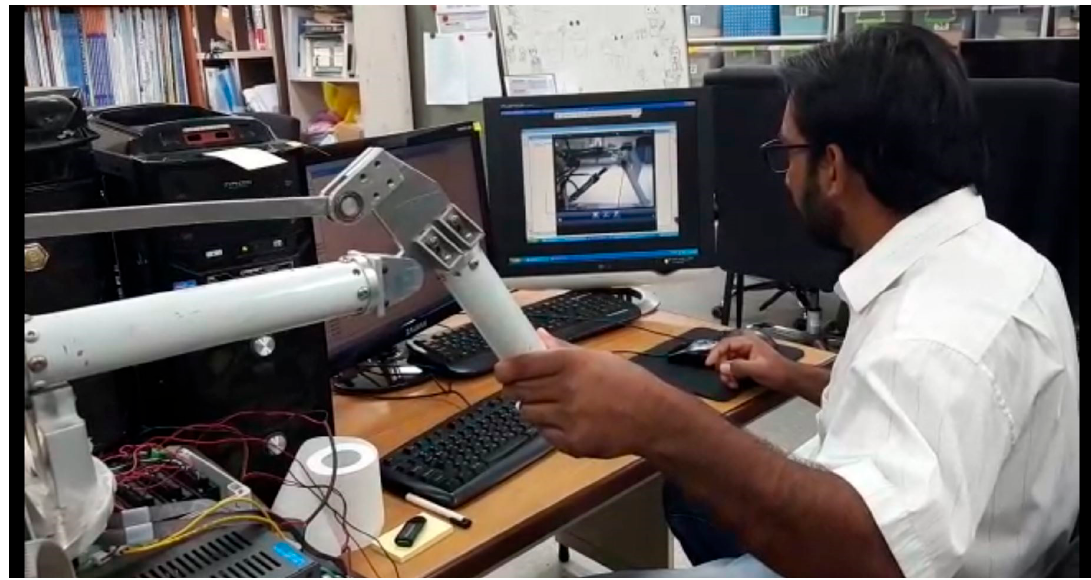
Figure 9. Video feedback.